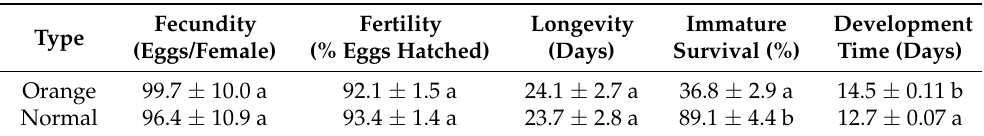
Table 2. Fecundity, fertility, longevity, immature survival and development time from egg to adult in the orange (mutant) and normal (wild) populations of Orius laevigatus . Type